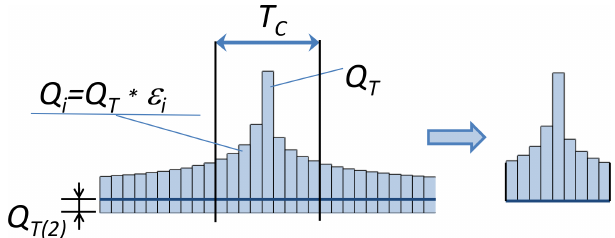
Figure 2. General scheme of flood hydrographs (adapted from Al- fieri et al., 2014).